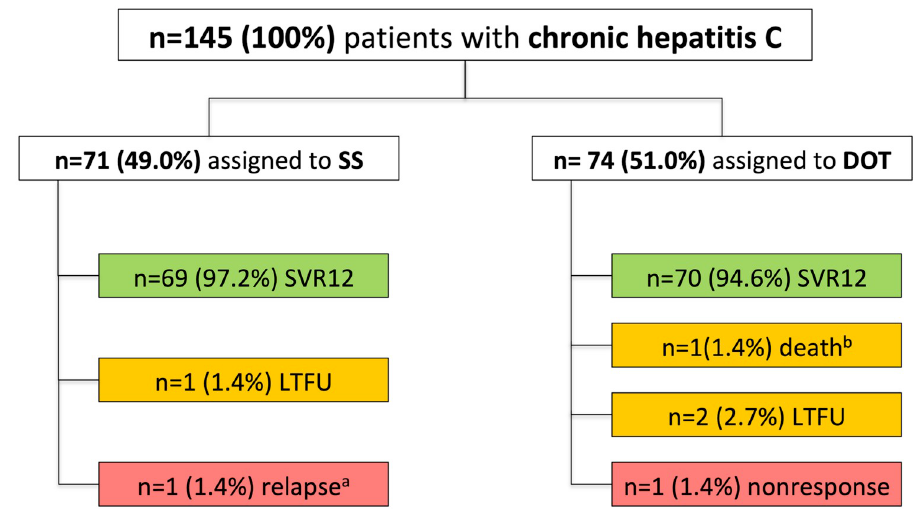
Fig 1. Flowchart of study patients. Abbreviations: SS, standard setting; DOT, directly observed therapy; SVR, sustained virologic response; LTFU, lost to follow-up. a at week 12 after end of therapy. b 16 weeks after end of treatment for reasons not related to therapy.